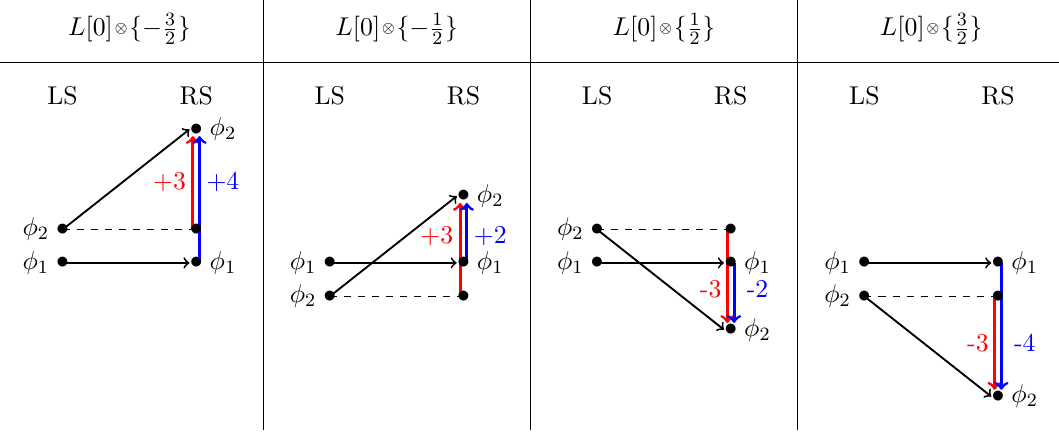
Figure 2 . Shift patterns of the conformal dimensions of the bosonic states within L [0] , as we go from the left- to the right-squashed S 7